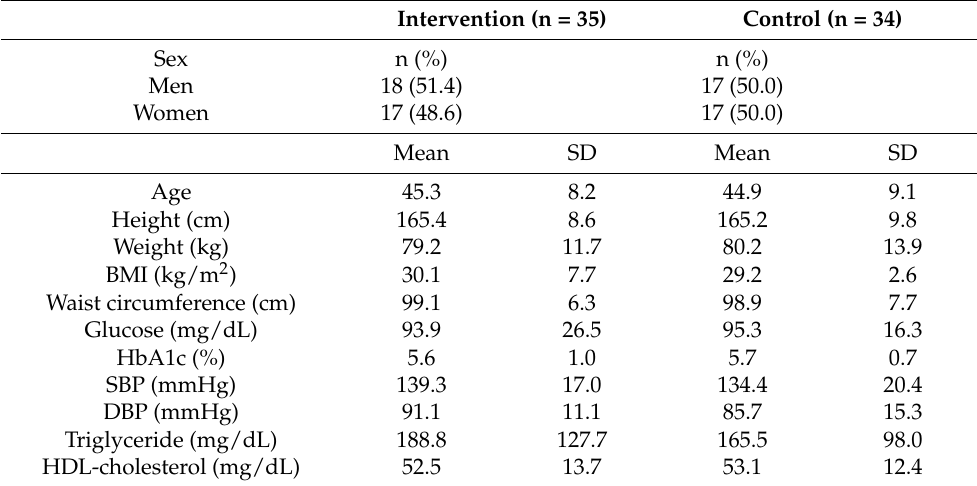
Table 1. Characteristics of study participants at baseline.